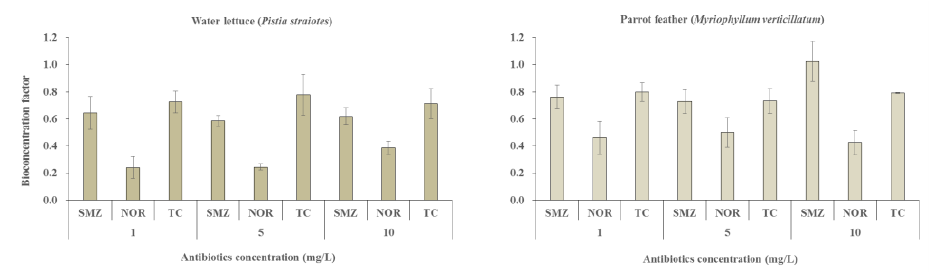
Figure 6. Bioconcentration factor (BCF) values of antibiotics in water lettuce and parrot feather plants (mean ± SD, n = 3).